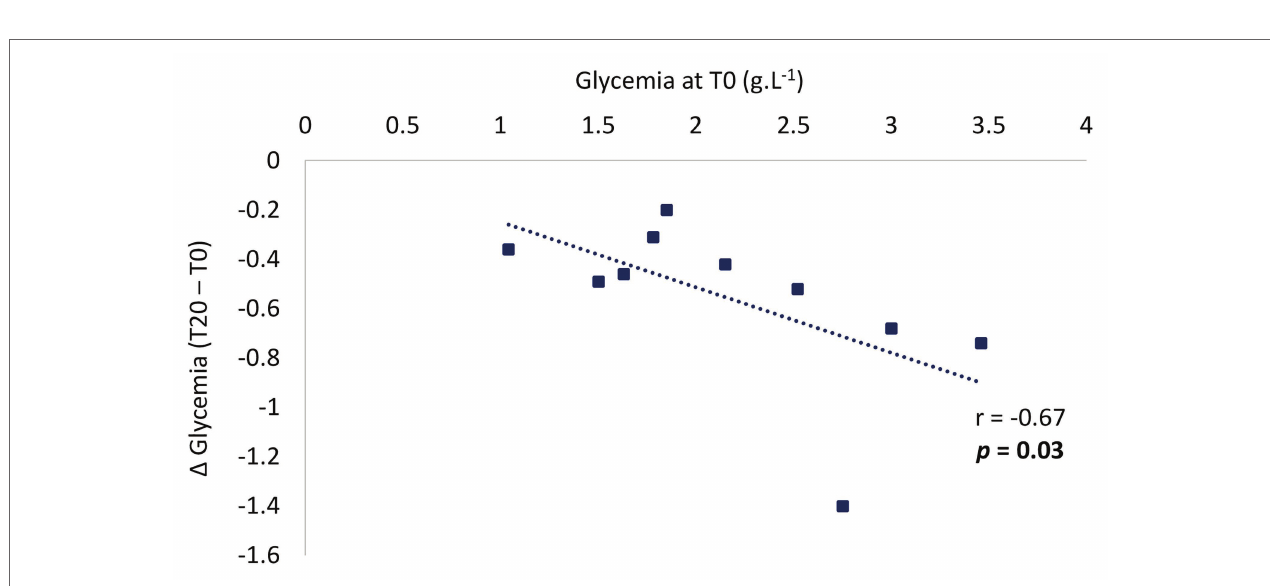
FIGURE 5 | Individual pre-exercise glycemia values according to the drop in glycemia during post-exercise in children with T1DM. The change in glucose concentrations during exercise was calculated from the delta of the end of exercise (T20) and pre-exercise value (T0). Two of the blood glucose data at T20 are missing due to an analytical